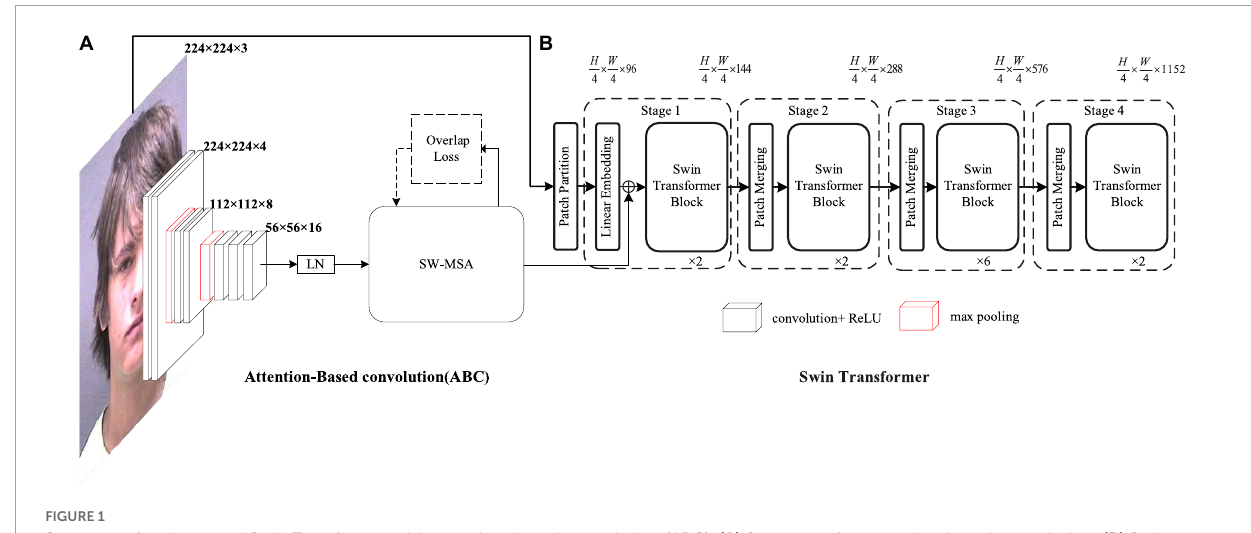
FIGURE1 Structure of an improved Swin Transformer with attention-based convolution (ABC). (A) Structure of an attention based convolution. (B) Swin